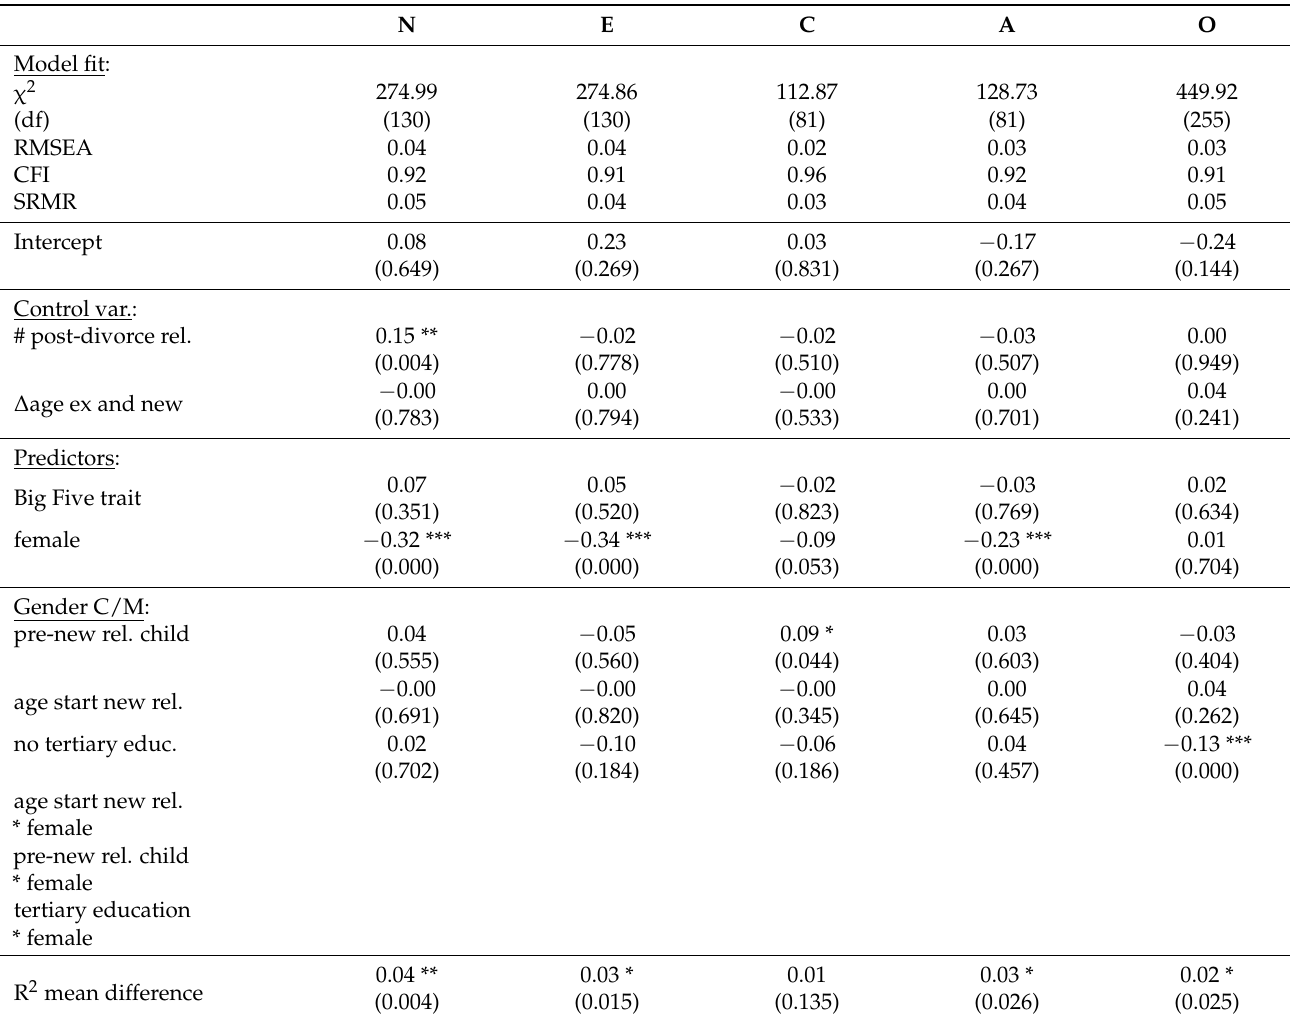
Table 2. Latent difference score models, including predictors. Positive mean difference scores indicate that the new partner outscores the